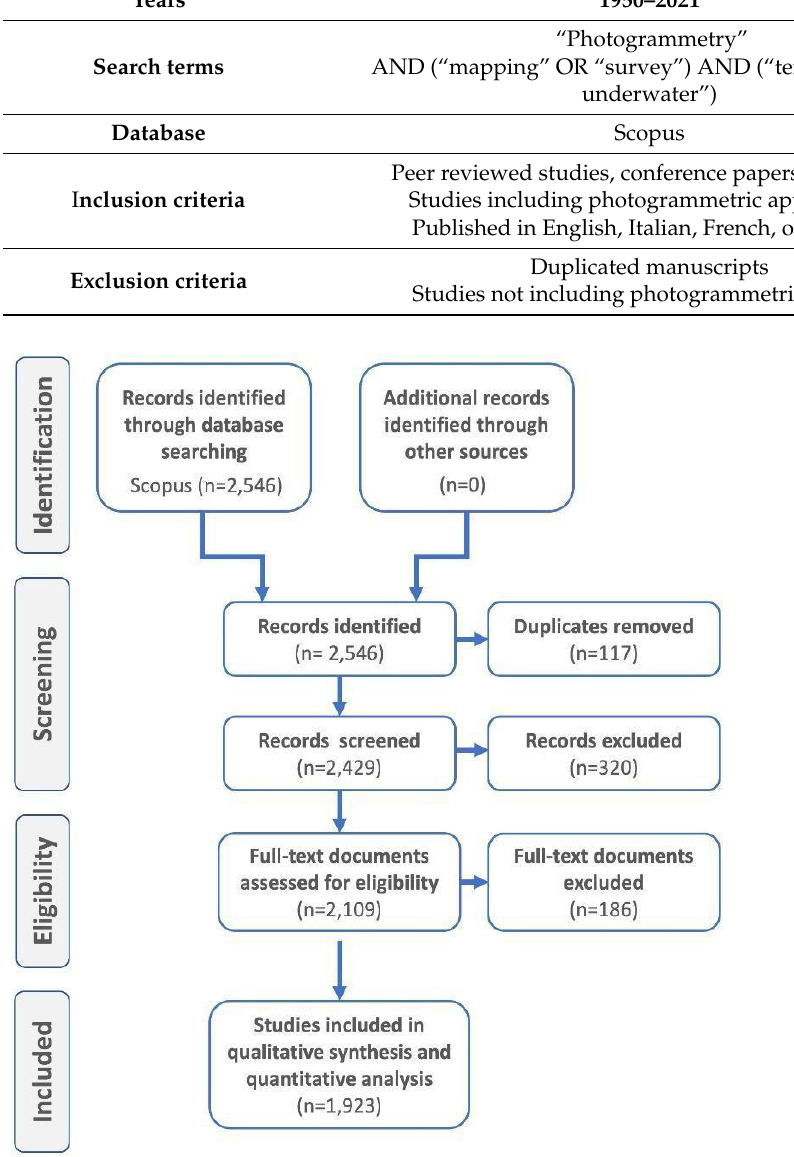
Figure 1. Flow diagram of the method and selection process implemented for this review effort.